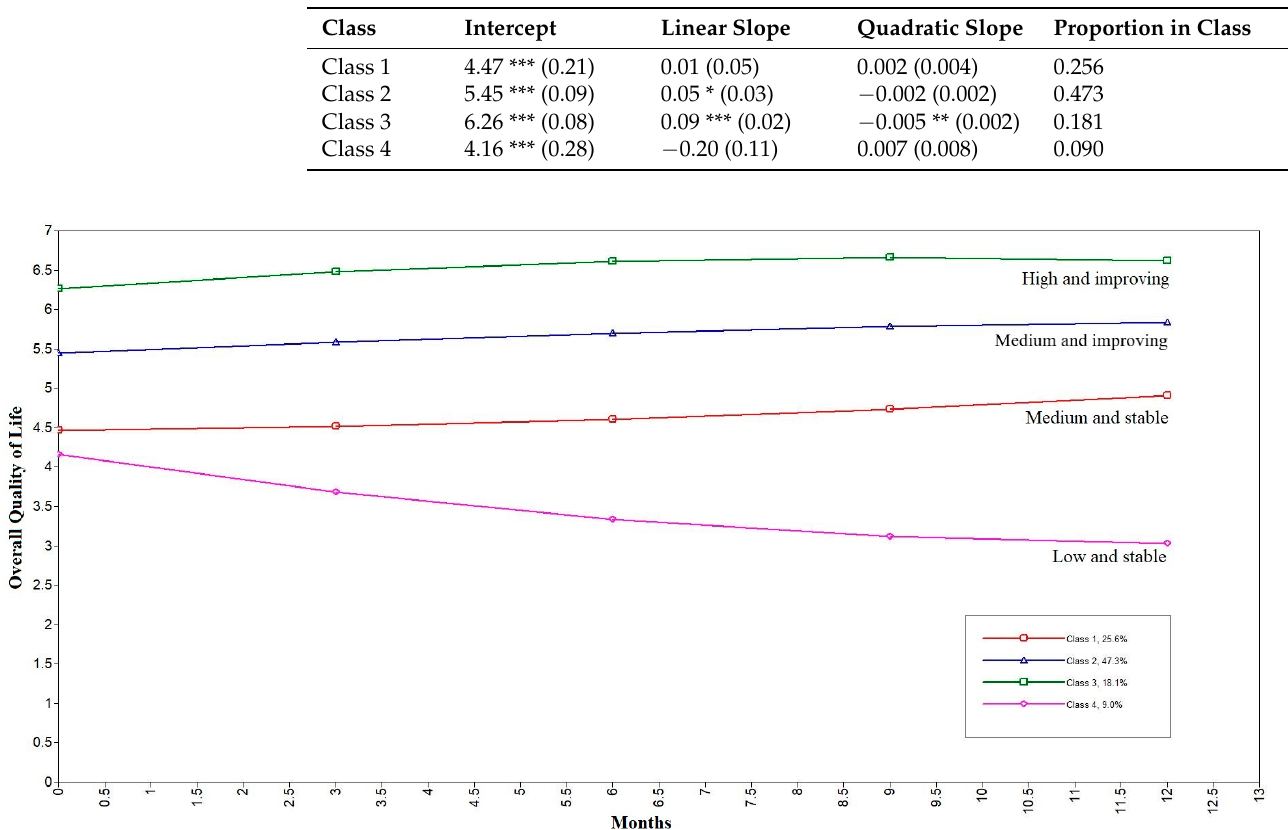
Figure 1. Trajectories of change in QoL in four classes (estimated